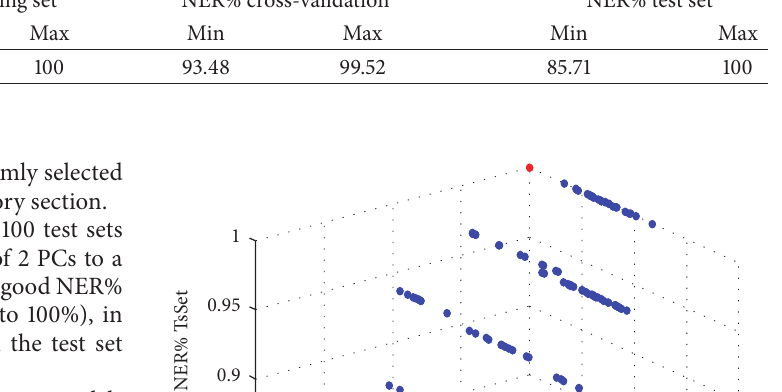
Figure 5: Score plot of PC1, PC2, and PC3 (a). The samples are separated along the three PCs in three clusters: untreated parchment sample (red), the parchment sample treated with castor oil (blue) and the parchment sample treated with glycerol (green). (b) represents the score plot of PC1 and PC2. Table 1: Results of LDA on the training and test sets and in cross-validation calculated on the 100 test sets. Number of PCs included NER% training set NER% cross-validation NER% test set